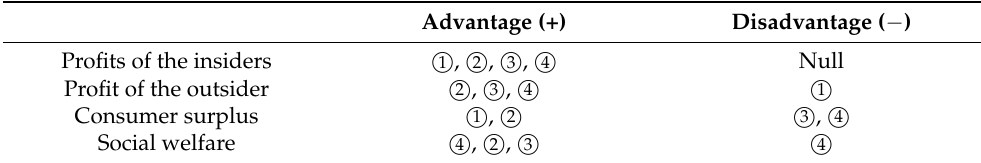
Table 2. Effects of merger with passive